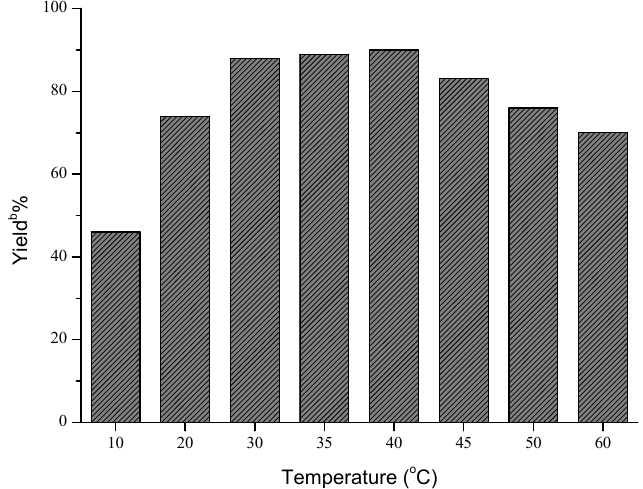
Figure 2. Influence of temperature on the Henry reaction a